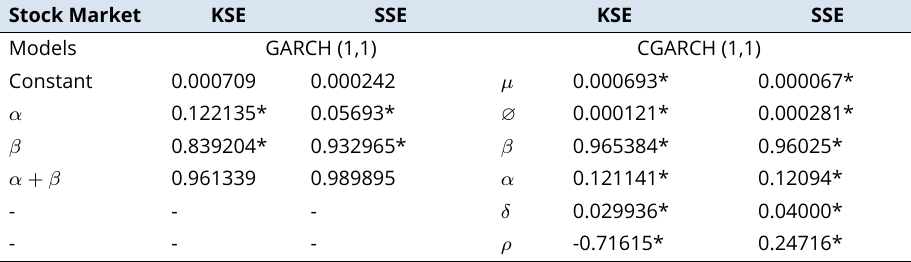
Results GARCH (1,1) and CGARCH (1,1) models